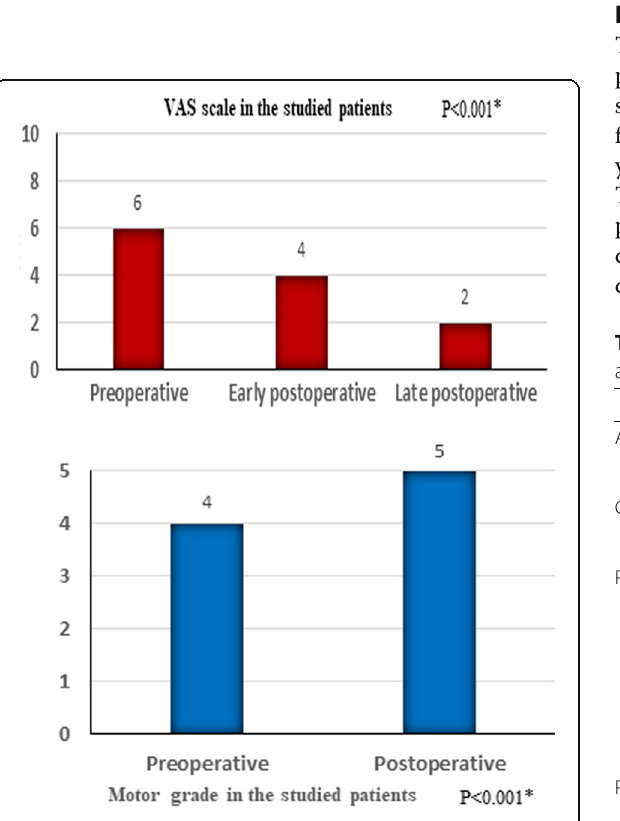
Fig. 4 a ( upper ) Bar chart showing a significant difference between median VAS score in preoperative and early and late postoperative periods by Friedman ’ s test ( p < 0.001). b ( Lower ) Bar chart showing a significant difference between median motor grade in preoperative and postoperative periods by Wilcoxon signed rank test ( p < 0.001)